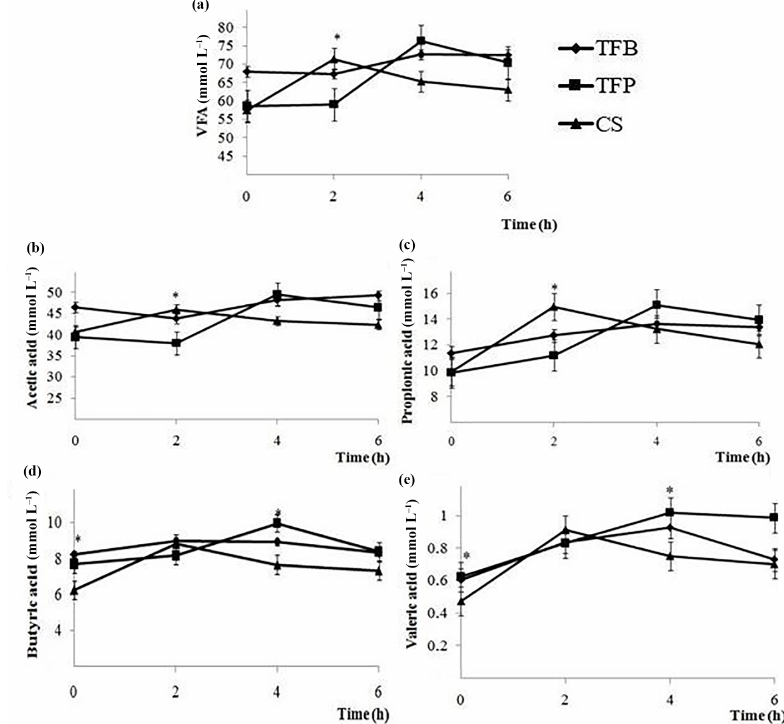
Figure 3. Total volatile fatty (a) , acetic (b) , propionic (c) , butyric (d) , and valeric (e) acid concentration (mmoll − 1 ) at 0, 2, 4, and 6h post feeding time in the rumen of ewes fed experimental concentrate (TFB, TFP, and CS) included in the ewes ration (1.8kgd − 1 of oat hay + 500gd − 1 of concentrate). Within a post-feeding time, * indicates differences among concentrates at P < 0.05.